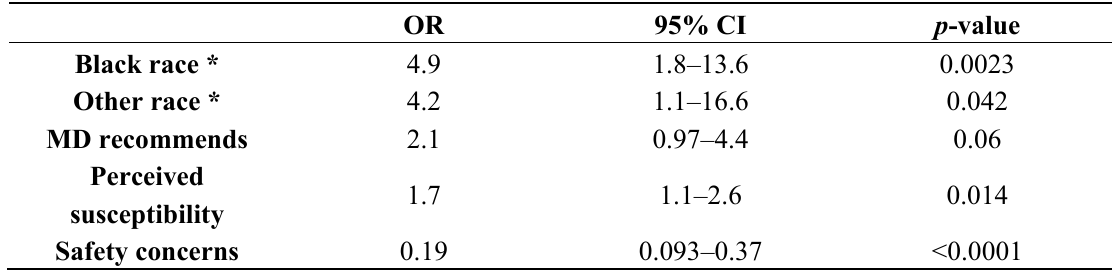
Table 3. Final regression model showing factors independently associated with initiating the HPV vaccine